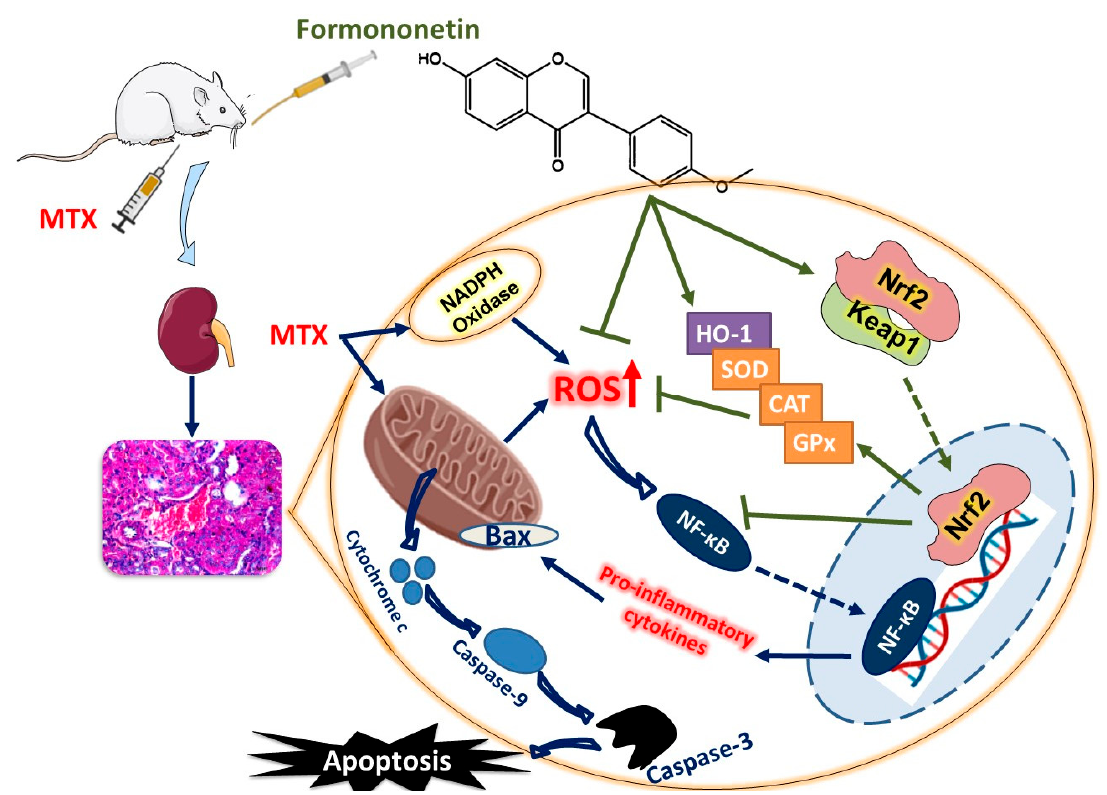
Figure 9. A schematic diagram illustrating the protective mechanism of FN against MTX nephrotoxicity. MTX provoked ROS generation, inflammation, and cell death in the kidney of rats. FN activated Nrf2/HO-1 signaling, boosted antioxidants, and prevented MTX-induced tissue injury.